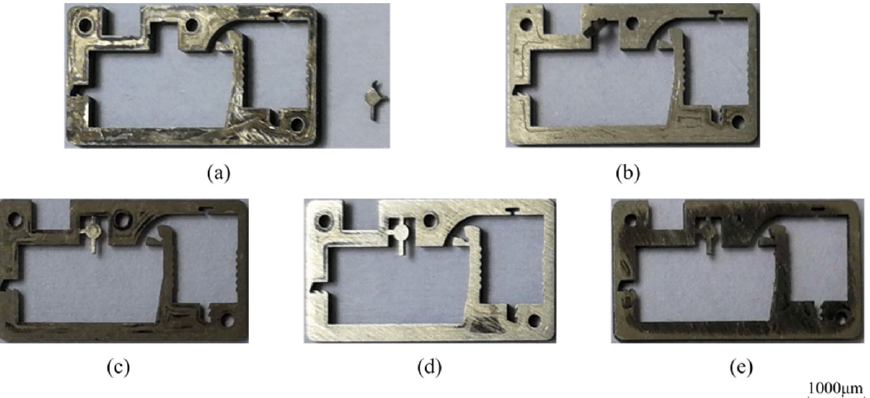
Figure 20. Test results of shear pin. ( a ) 70 N; ( b ) 40 N; ( c ) 25 N; ( d ) 30 N; ( e ) 35 N. Table 3. Results of test sample points.